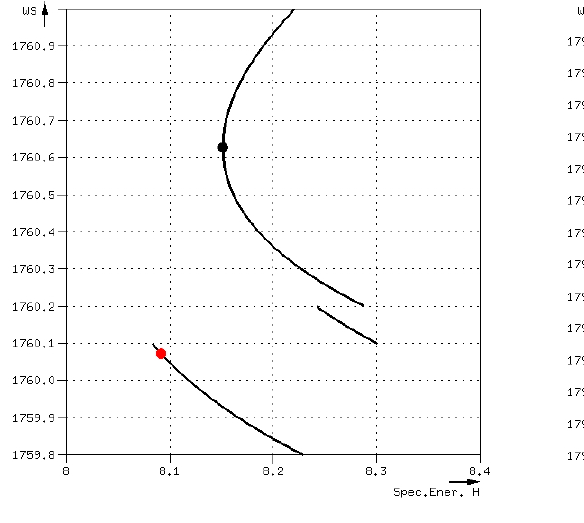
Figure 16 . Dataset 3: Critical depths of case 4 ( a ) section 7 and ( b ) section 39